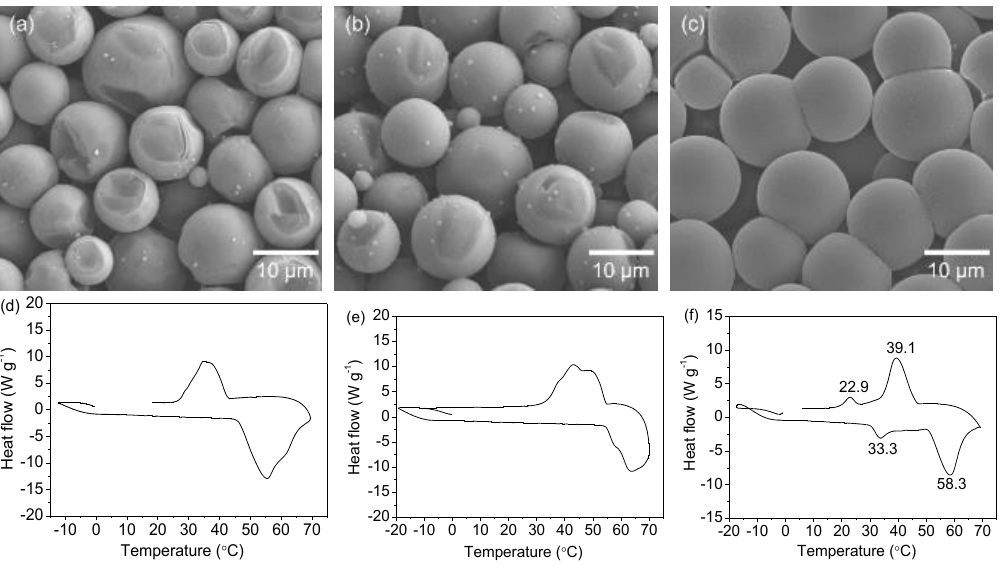
Figure 9. SEM images of the microcapsules encapsulated with ( a ) n -docosane, ( b ) n -hexacosane, and ( c ) a mixture of n -docosane and n -hexacosane (weight ratio = 1:1). Corresponding DSC curves (at a scanning rate of 10 °C·min − 1 ) of the capsules encapsulated with ( d ) n -docosane, ( e ) n -hexacosane, and ( f ) a mixture of n -docosane and n -hexacosane.